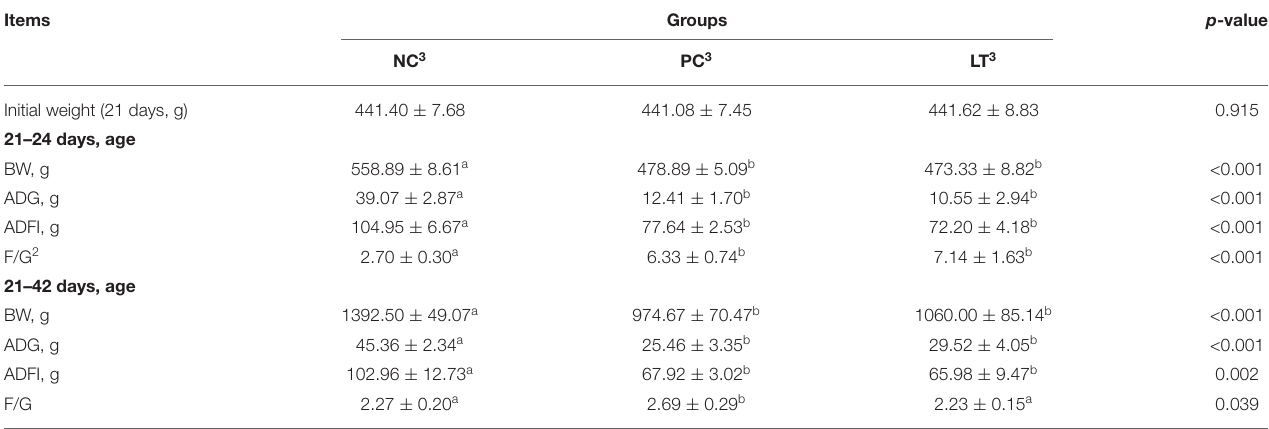
TABLE 2 | Effects of dietary L-theanine on the performance of broilers under the oxidative stress 1 . Items